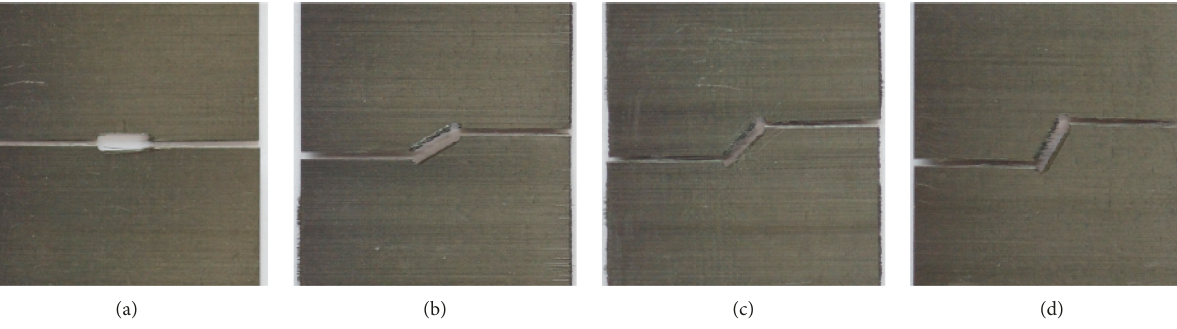
Figure 9: Final failure morphology of four B-type composite specimens. (a) β � 0 ° . (b) β � 30 ° . (c) β � 45 ° . (d) β � 60 °